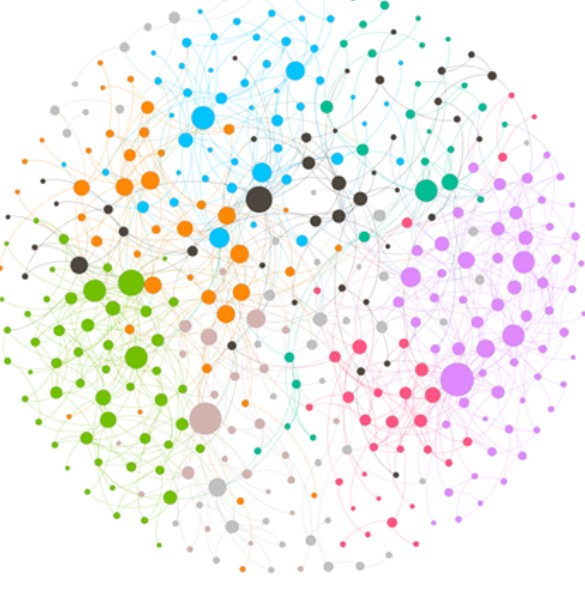
Figure 11. Citation Network (WOS) Table 5. Citation analysis